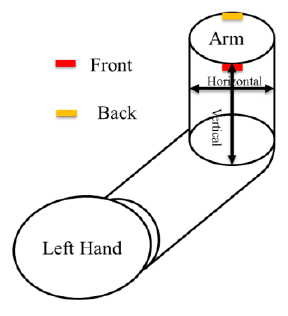
Figure 2. The definition for the horizontal and vertical direction on the arm. Red color represents the front side, the yellow-brown color represents the back side.